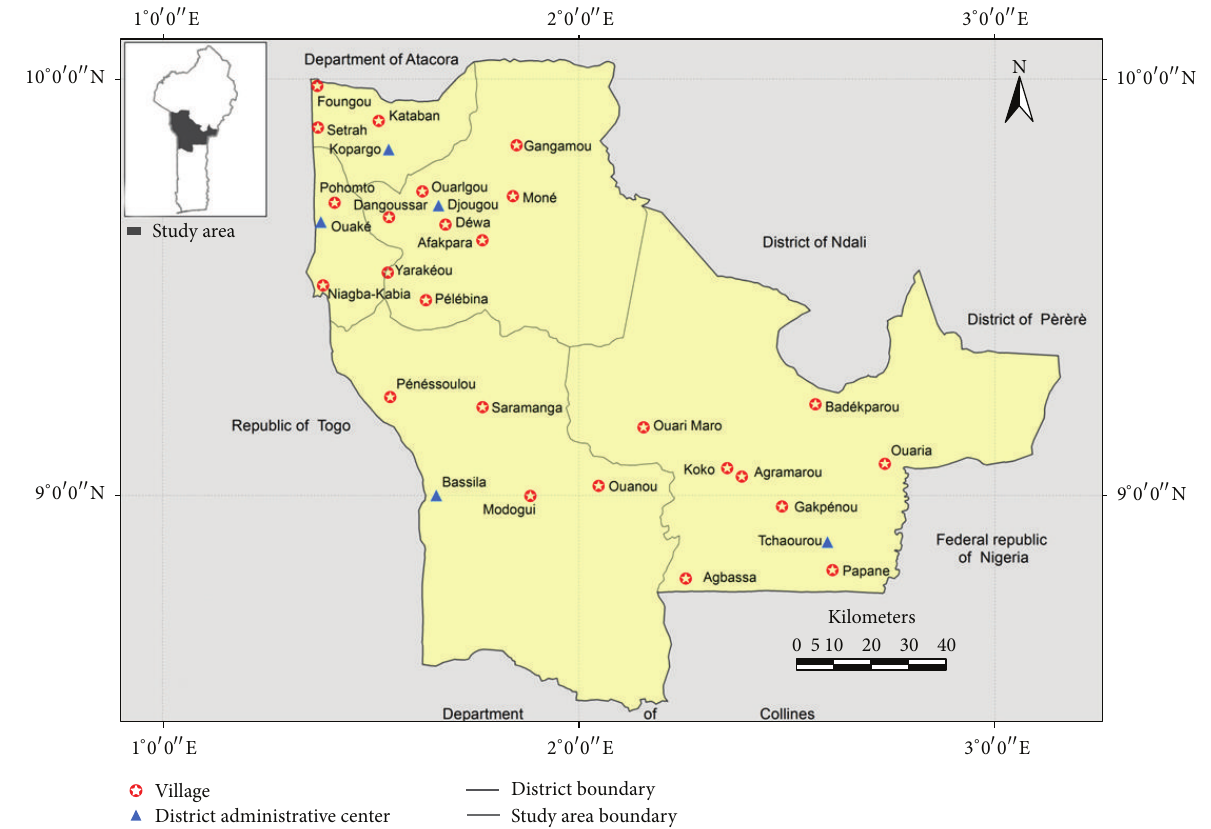
Figure 1: Map of Benin showing the geographical position of the surveyed